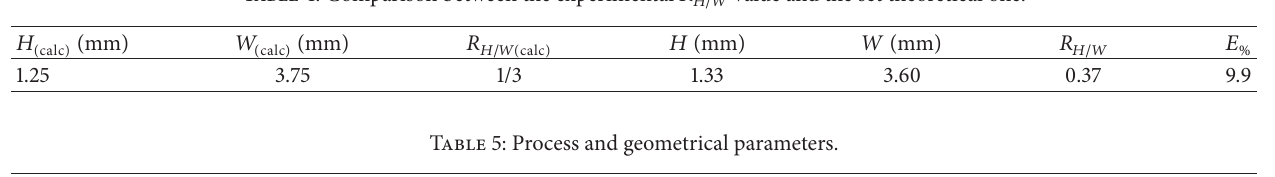
Table 4: Comparison between the experimental 𝑅 𝐻/𝑊 value and the set theoretical one.